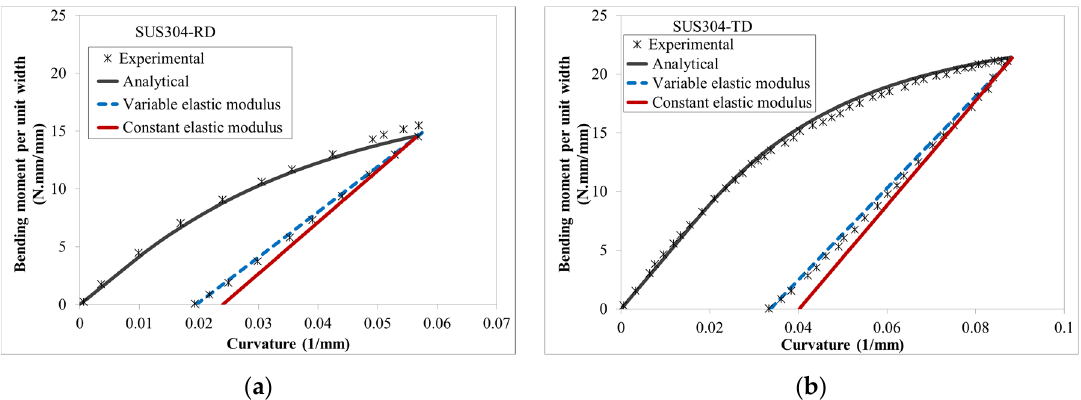
Figure 9. Comparison of the analytical and experimental bending moment–curvature diagram and nonlinear unloading in the ( a ) rolling direction and ( b ) transverse direction.